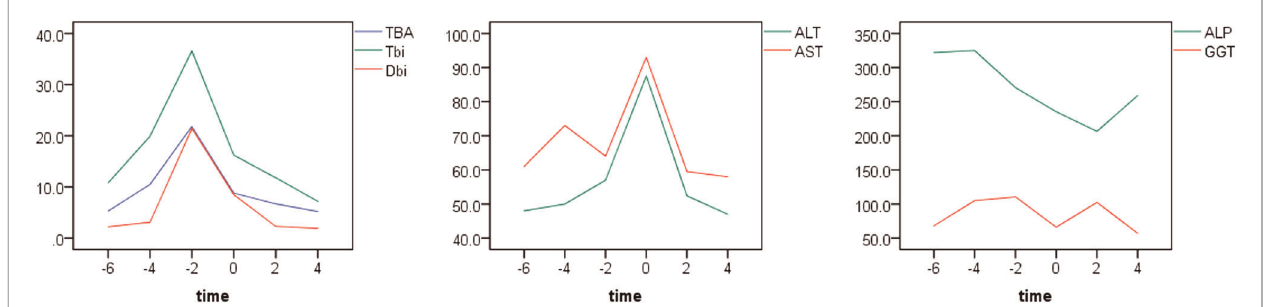
FIGURE 1 | Hepatic function from 6 weeks before anastomosis to 4 weeks after anastomosis. The “ zero ” on the x-axis represents the time point when anastomosis was performed.